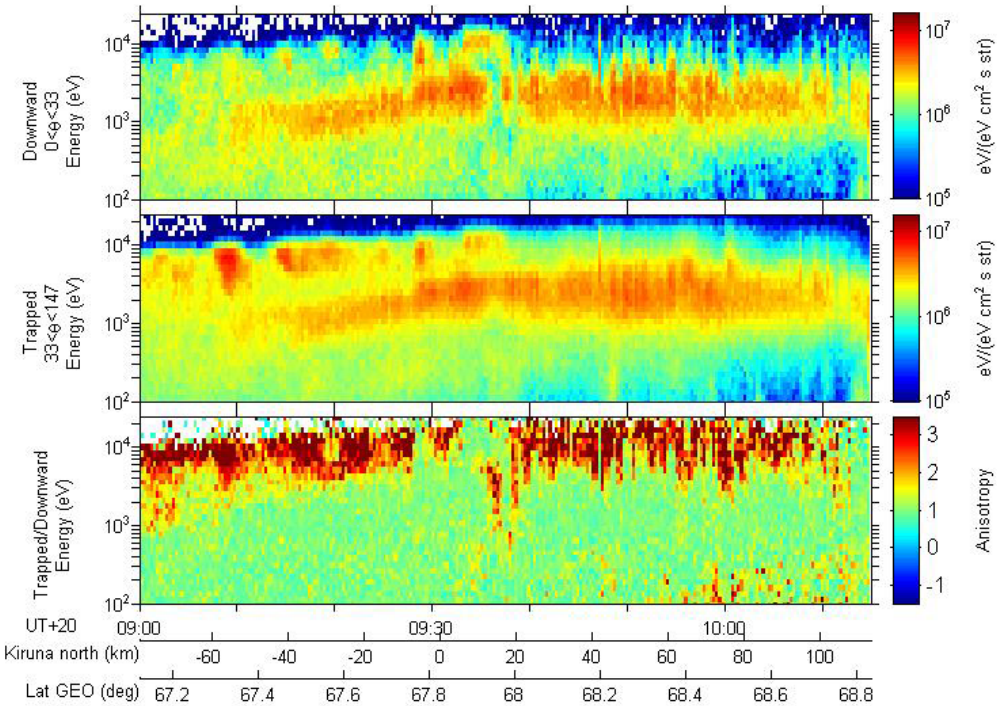
Fig. 9. Downward (upper panel) and trapped (middle panel) differential electron energy fluxes. The bottom panel shows anisotropy coeffi- cients as function of energy and time. The anisotropy values can only be positive, but the pseudo colour scale varies from negative to positive values in order to contrast anisotropy variations at higher energies.